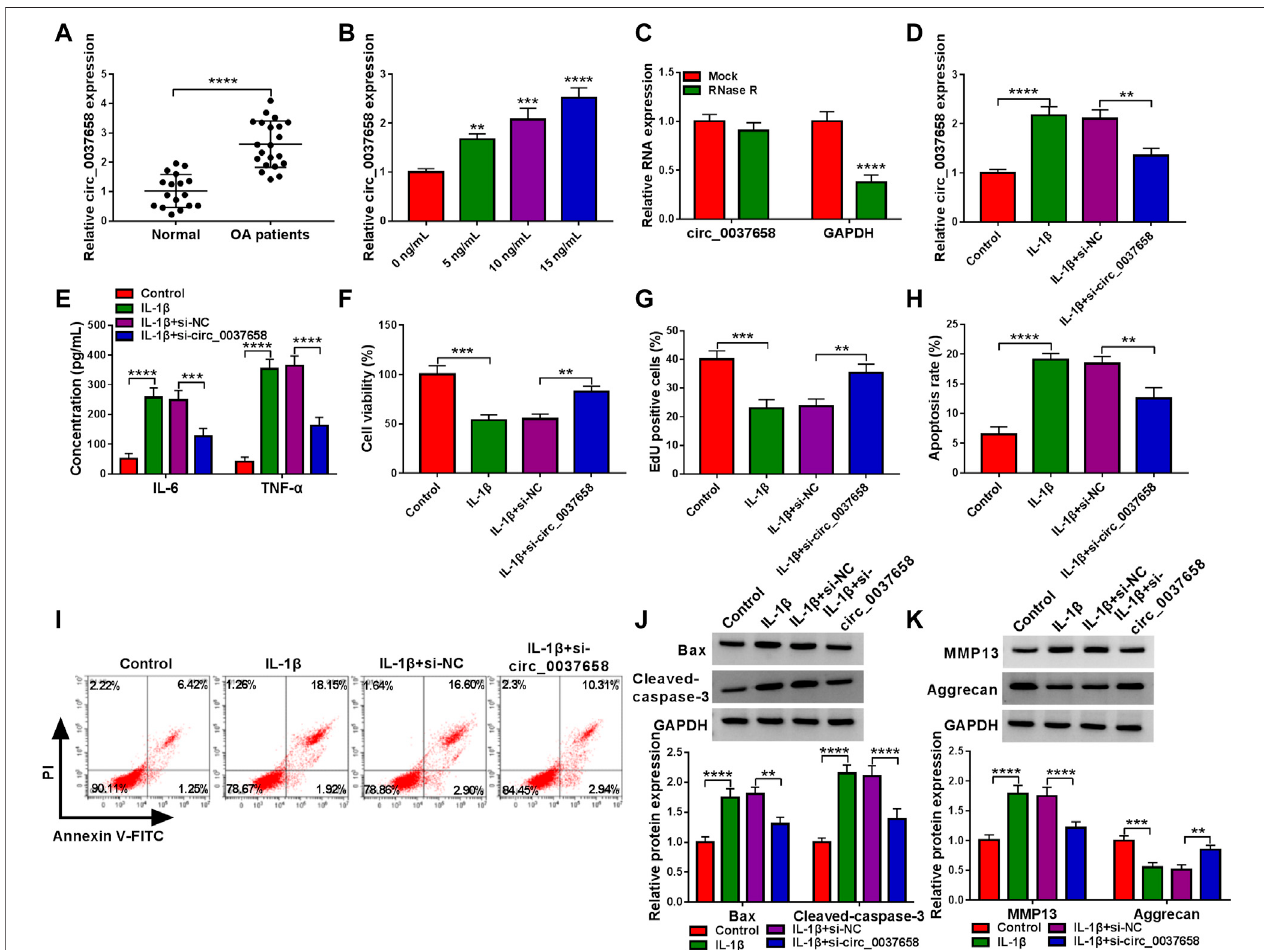
FIGURE 2 | IL-1 β -triggered chondrocyte injury was abolished by circ_0037658 silencing. (A) RT-qPCR analysis of circ_0037658 expression level in 21 OA cartilage tissues and 17 healthy cartilage tissues (**** indicates p < 0.0001, relative to the control group). (B) Relative circ_0037658 expression in CHON-001 cells was detectedusingRT-qPCRassaywithdifferentdosesofIL-1 β (**, ***or****indicates p < 0.01, p < 0.001,or p < 0.0001relativetothe0 ng/mlIL-1 β groups). (C) RT-qPCR analysis of circ_0037658 expression after treatment with RNase R in CHON-001 cells. (D – K) CHON-001 cells were treated with IL-1 β , IL-1 β +si-NC, IL-1 β +si- circ_0037658, or without (Control) (**** indicates p < 0.0001 relative to the Mock group). (D) The expression level of circ_0037658 was gauged in treated CHON-001 cells using RT-qPCR assay. (E) The concentration of IL-6 and TNF- α in treated CHON-001 cells was analyzed using ELISA Kit. (F,G) CHON-001 cell proliferative ability was determined using CCK-8 assay and EdU assay. (H,I) CHON-001 cell apoptosis rate in different groups was monitored using fl ow cytometry assay. (J,K) Western blot analysis of Bax, Cleaved-caspase-3, MMP13, and Aggrecan protein levels in treated CHON-001 cells, and GAPDH was used as a loading control. (D – K) : *** or **** indicates p < 0.001 or p < 0.0001 when IL-1 β group wascompared to the negative control group and **,***, or **** indicates p < 0.01, p < 0.001 or p < 0.0001 when IL- 1 β +si-circ_0037658 group was compared to the IL-1 β +si-NC group). These results were presented as the mean ± (SD), n = 3. ** p < 0.01, *** p < 0.001, **** p < 0.0001.